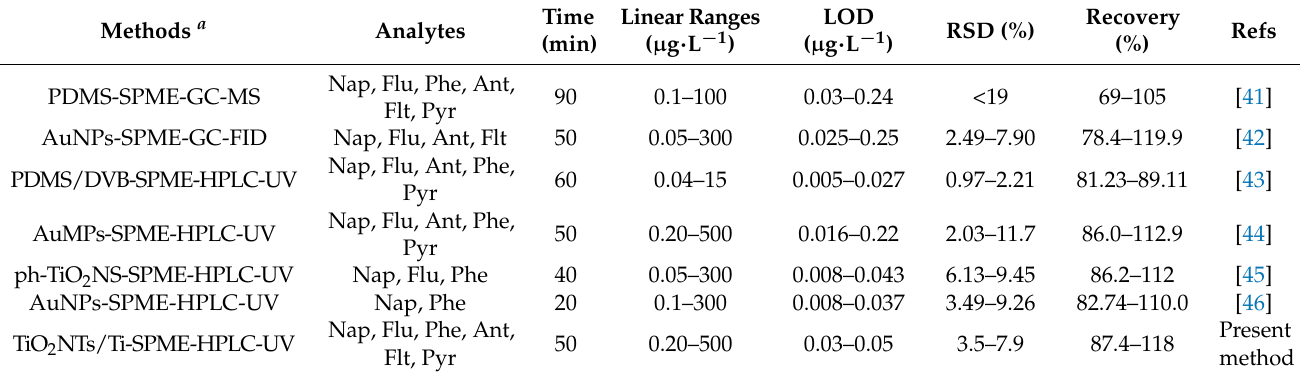
Table 3. Comparison of the proposed method with other reported